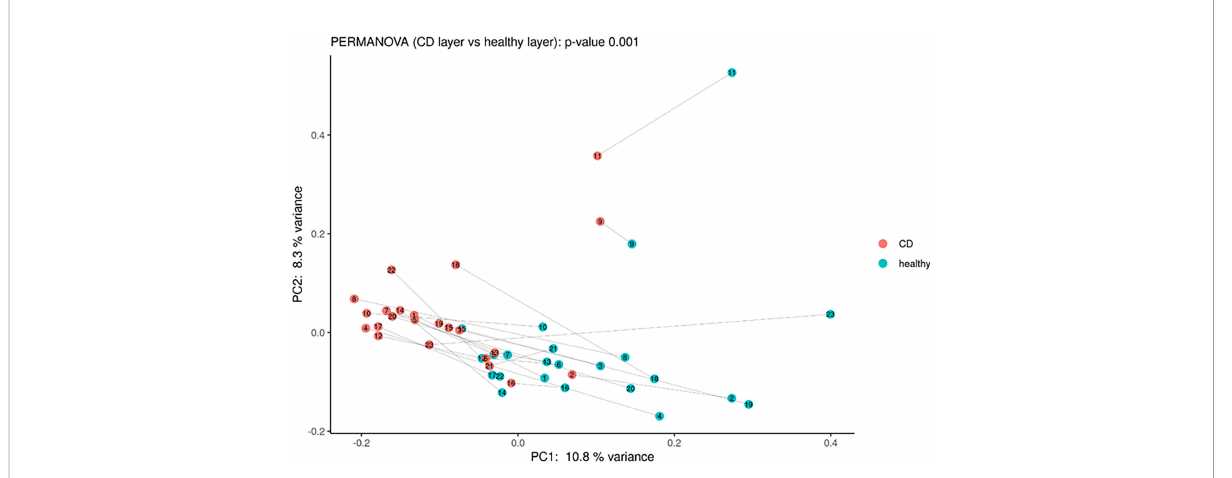
FIGURE 3 Principal coordinate analysis using Bray – Curtis dissimilarity as a distance metric on square root – transformed percent abundance of identi fi ed OTUs showing permuted p – value of general b dispersion and pairwise b dispersion of CD and healthy groups. The lines connect the samples from the same